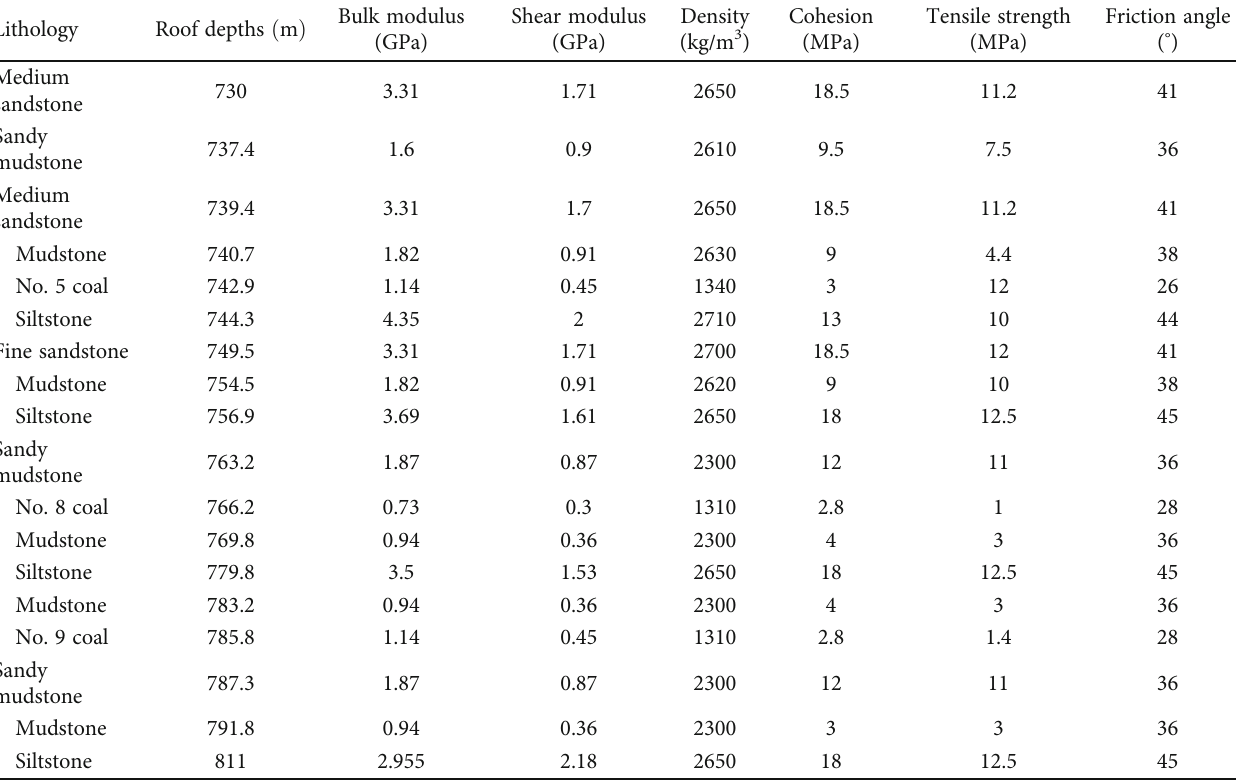
Table 1: Rock material parameters.